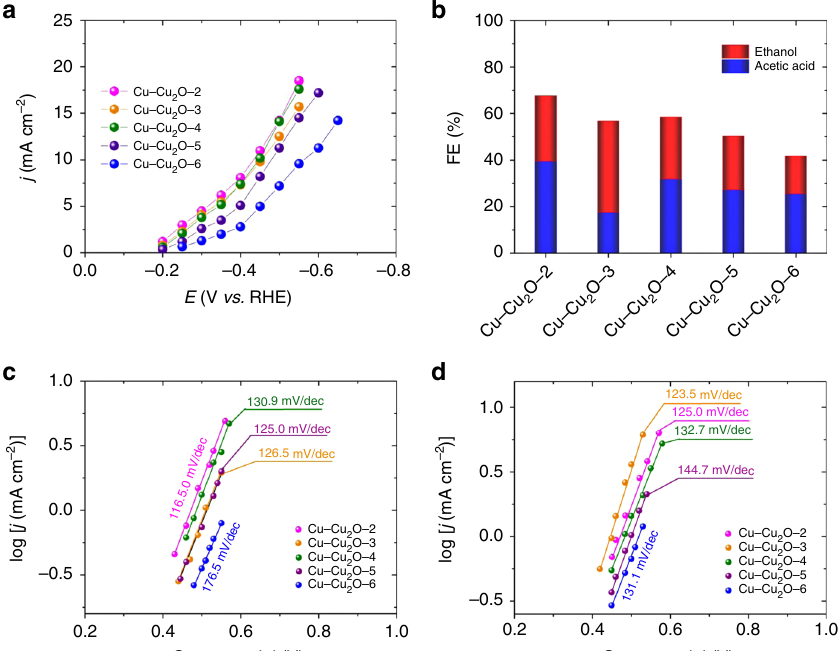
Fig. 4 Carbon dioxide reduction over copper – cuprous oxide electrodes prepared using ligands two to six. a The total current density at different applied potentials; b Faradaic ef fi ciencies of the C 2 products at applied potential of − 0.4 V vs RHE. c , d Dependence of partial current density of acetic acid and ethanol on overpotential, respectively. Data were collected at room temperature and ambient pressure; electrolyte, 0.1 M KCl; CO 2 stream, 5